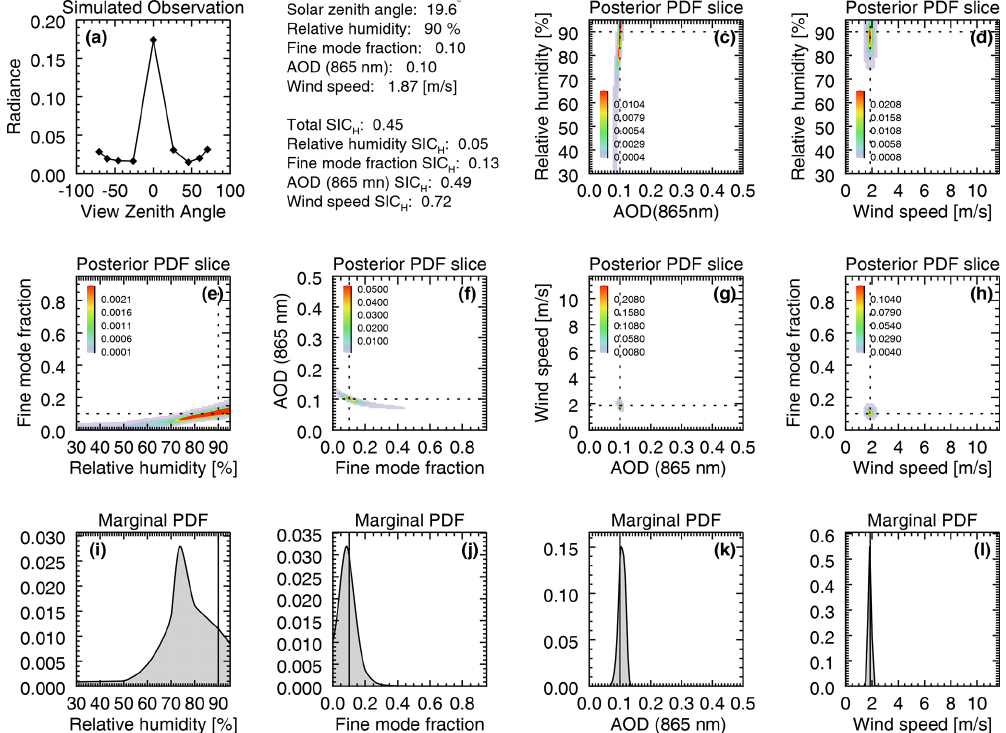
Figure 7. GENRA results for a retrieval with the same parameters as in Fig. 3, but for test case F. The solar zenith angle is θ s = 19 . 6 ◦ , so the sun glint is centered about the most nadir view camera, An. Parameters remain the same, with r = 90%, f = 0 . 10, τ = 0 . 10, and w = 1 . 87ms − 1 , while overall SIC H decreases further to 0 .